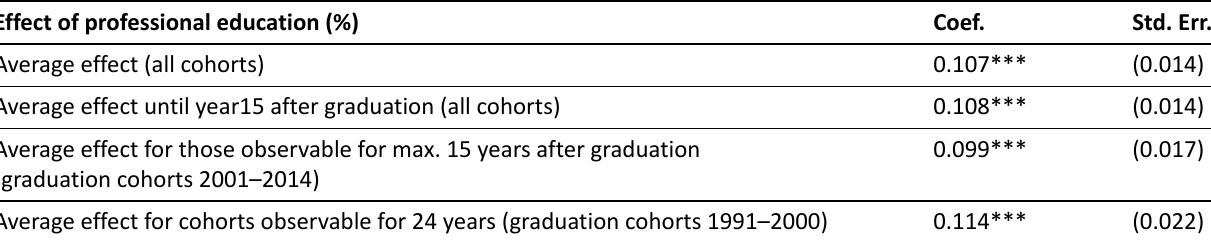
Table A3. Results of (weighted) quasi-panel fixed effects